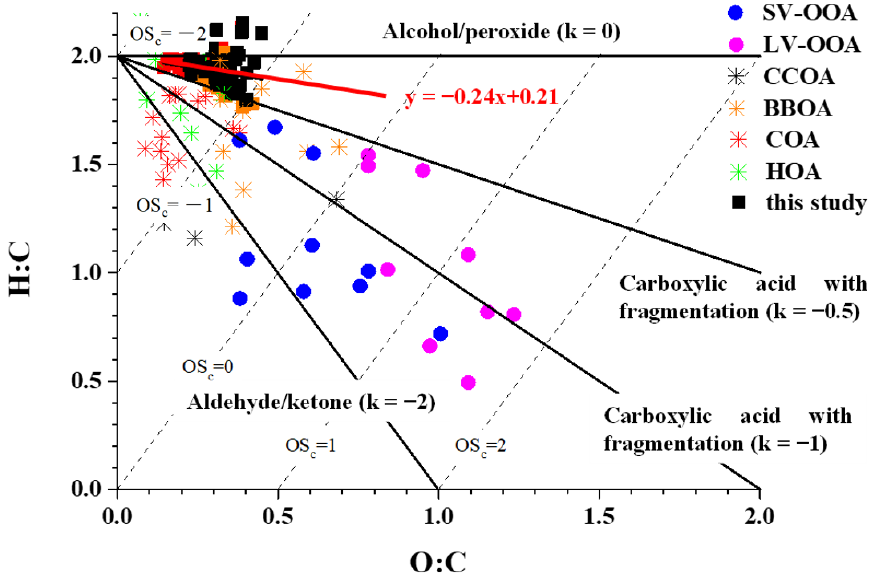
Figure 5. The Van Krevelen-OSc diagram. The meanings of the symbols are the same as those in Figure 3, and the detailed information is also summarized in Tables S2 and S3 in the Supplementary Materials. The dashed lines represent the average carbon oxidation state [57] and the slopes represent the different functionalization processes of organic species [56].